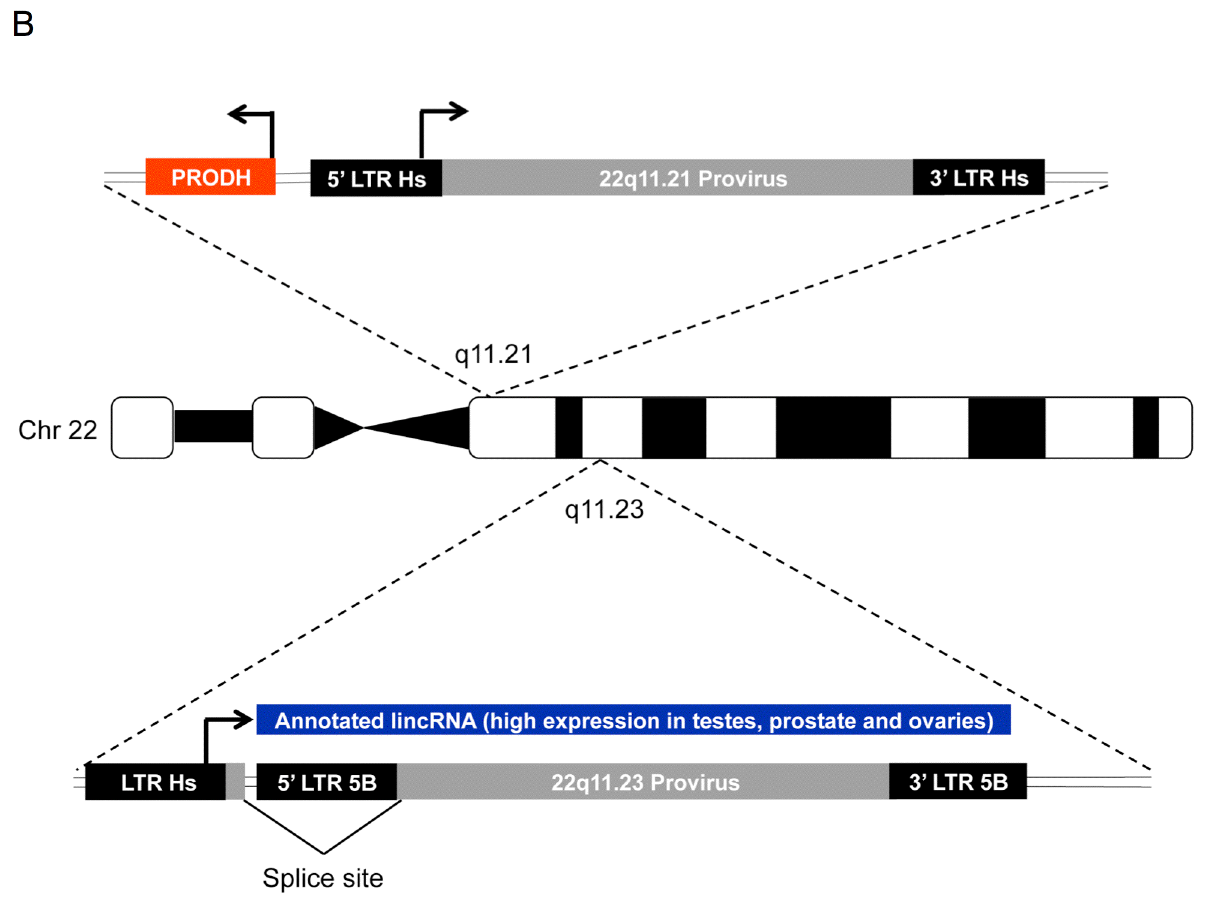
Figure 4. Transcription of HML-2 proviruses is driven by the native LTR or a nearby element. ( A ) Neighbor-joining tree of the 5’ LTR sequences of the HML-2 proviruses expressed in Tera-1 cells. The p-distance method was used to calculate distance and bootstrap values are indicated (1000 replicates). Proviruses with (*) were predicted to be underrepresented by the in silico analysis, as in Figure 1. Solid squares ( ∎ ) indicate those proviruses (11q23.3 and 11q12.3) with minus strand transcription. Solid diamonds (♦) indicate those proviruses (4p16.3a and 22q11.23) with plus strand transcription, but which appear to originate from a neighboring transcription unit and not the corresponding 5’ LTR. ( B ) A cartoon of two proviruses located on chromosome 22 and their method of transcription. Provirus 22q11.21 (LTR Hs, FPKM = 26.11) is located 2.1 kb downstream from the expressed gene PRODH (Proline Dehydrogenase (oxidase) 1, FPKM = 11.53) but in the opposite transcriptional orientation. The 5’ LTR of 22q11.21 appears to drive proviral transcription in Tera-1 cells. Provirus 22q11.23 (FPKM = 26.94) appears to be transcribed solely through the use of an LTR Hs (FPKM = 0.31) located 551 bp upstream from the provirus. This transcript coincides with an annotated lincRNA (large intergenic non-coding RNA) [59]. See supplemental Figures S3 and S4 for more detail. Cartoon is not drawn to